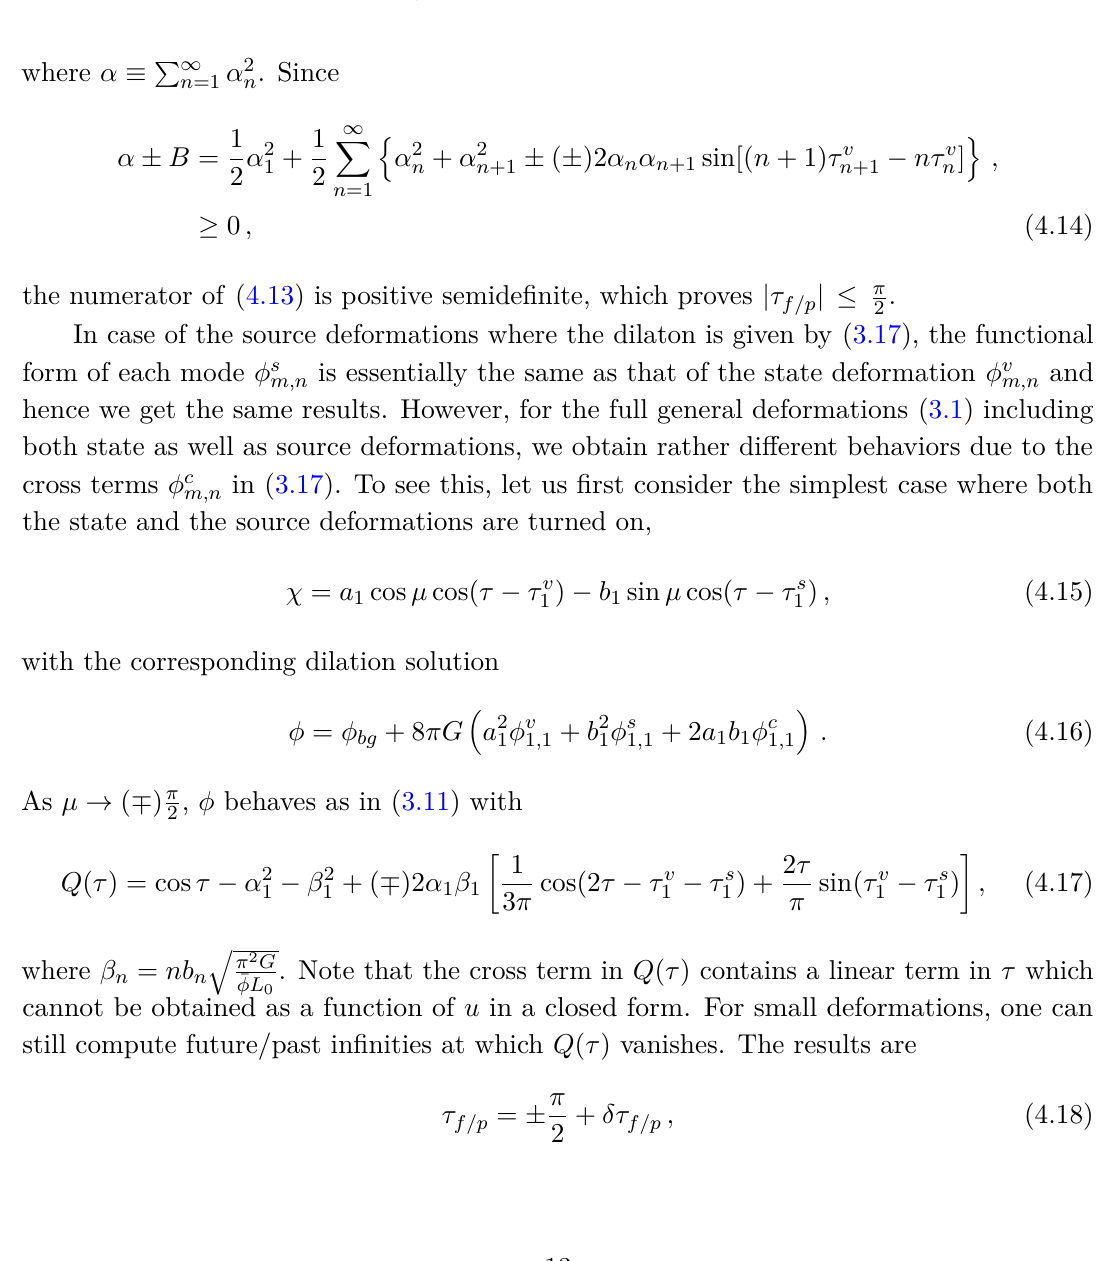
Figure 2 . Penrose diagram of deformed two-sided black hole